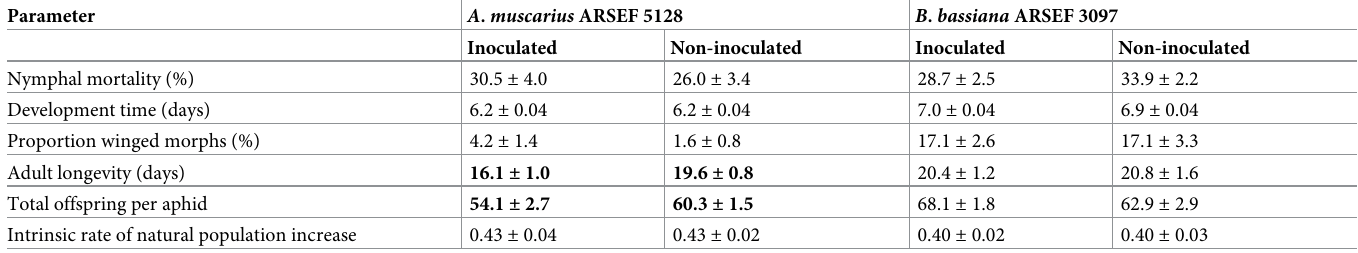
Table 2. Life history parameters 1 of Myzus persicae var. nicotianae fed on sweet pepper plants inoculated with Akanthomyces muscarius ARSEF 5128 or Beauveria bassiana ARSEF 3097, compared to non-inoculated plants 2